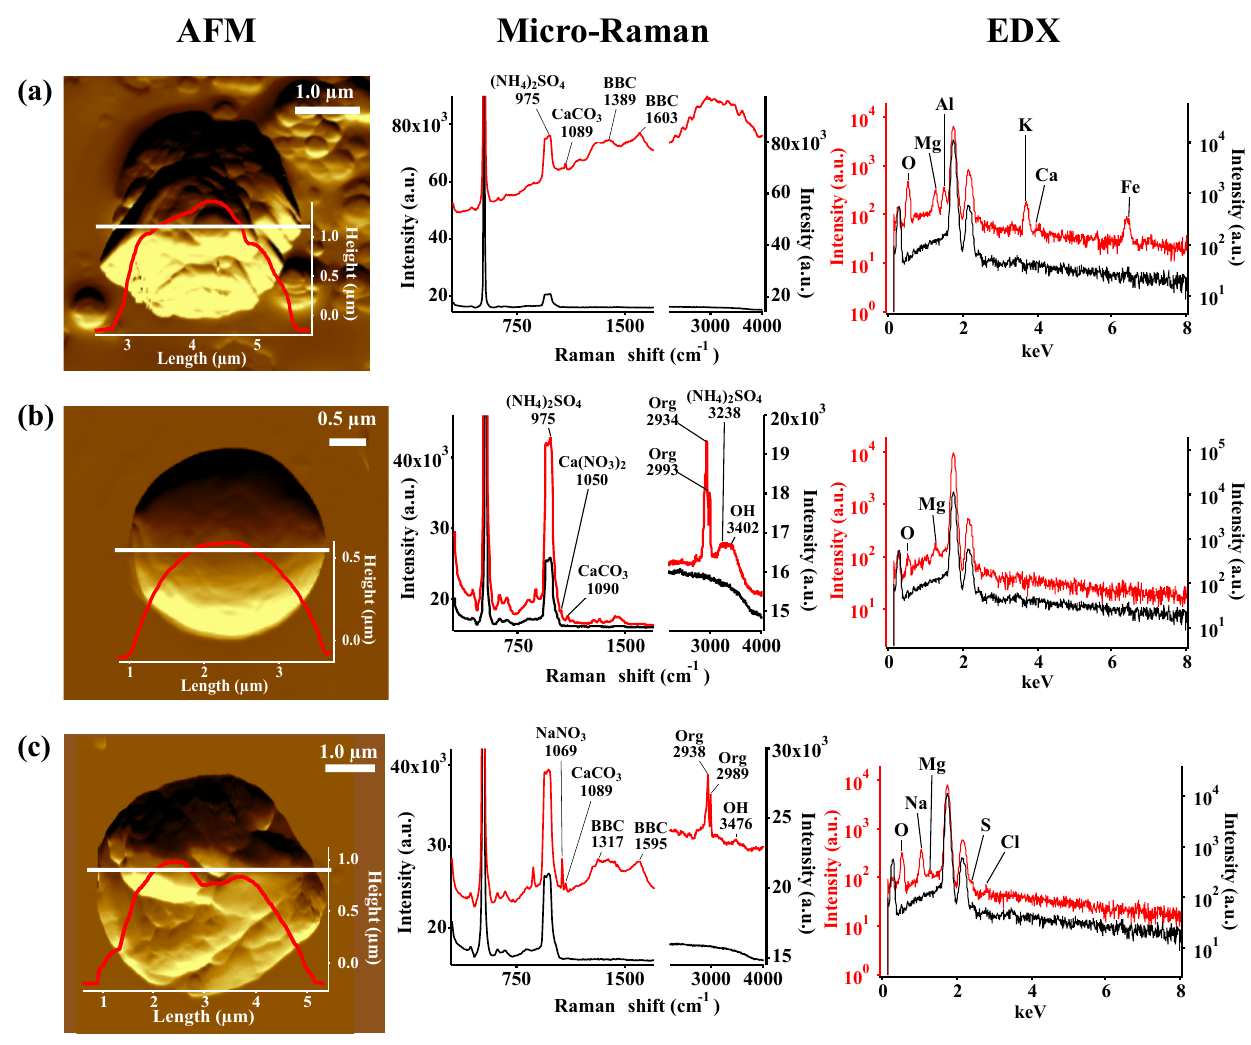
Figure 3. AFM topographic images of representative IN active particle (a) and non-active particle (b, c) groups, and their corresponding Raman and EDX spectra. The AFM images were obtained in probe amplitude mode. The inset in the AFM image shows the scanned height along the white transect of each particle. The red and black curves indicate the spectra of the particles and the substrate background,